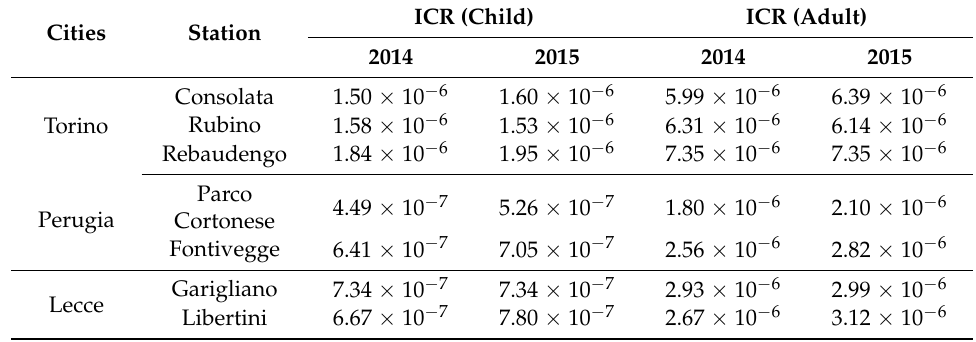
Table 5. Increased cancer risk (ICR) associated with exposure to benzene in Torino, Perugia, and